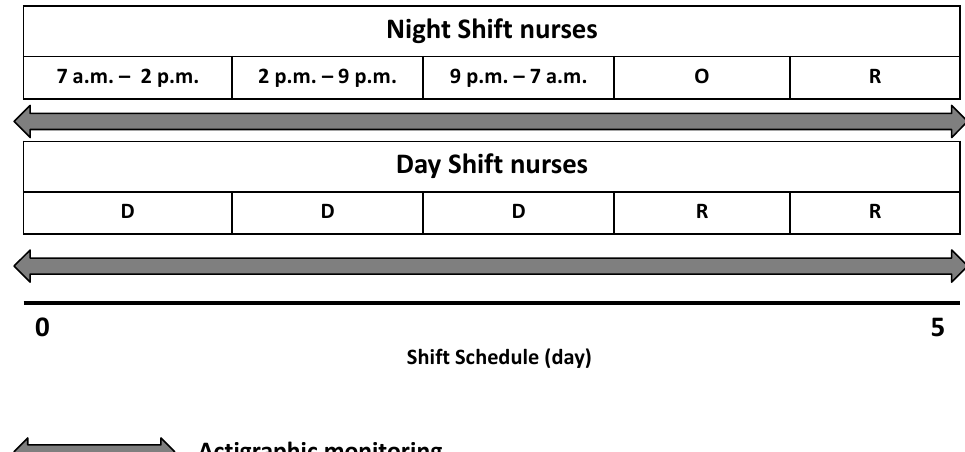
Figure 2. Shift schedule for night shift (NS) and day shift (DS) nurses. The grey indicators denote the duration of actigraphic monitoring. O: night-off; R: rest; D: diurnal shift.